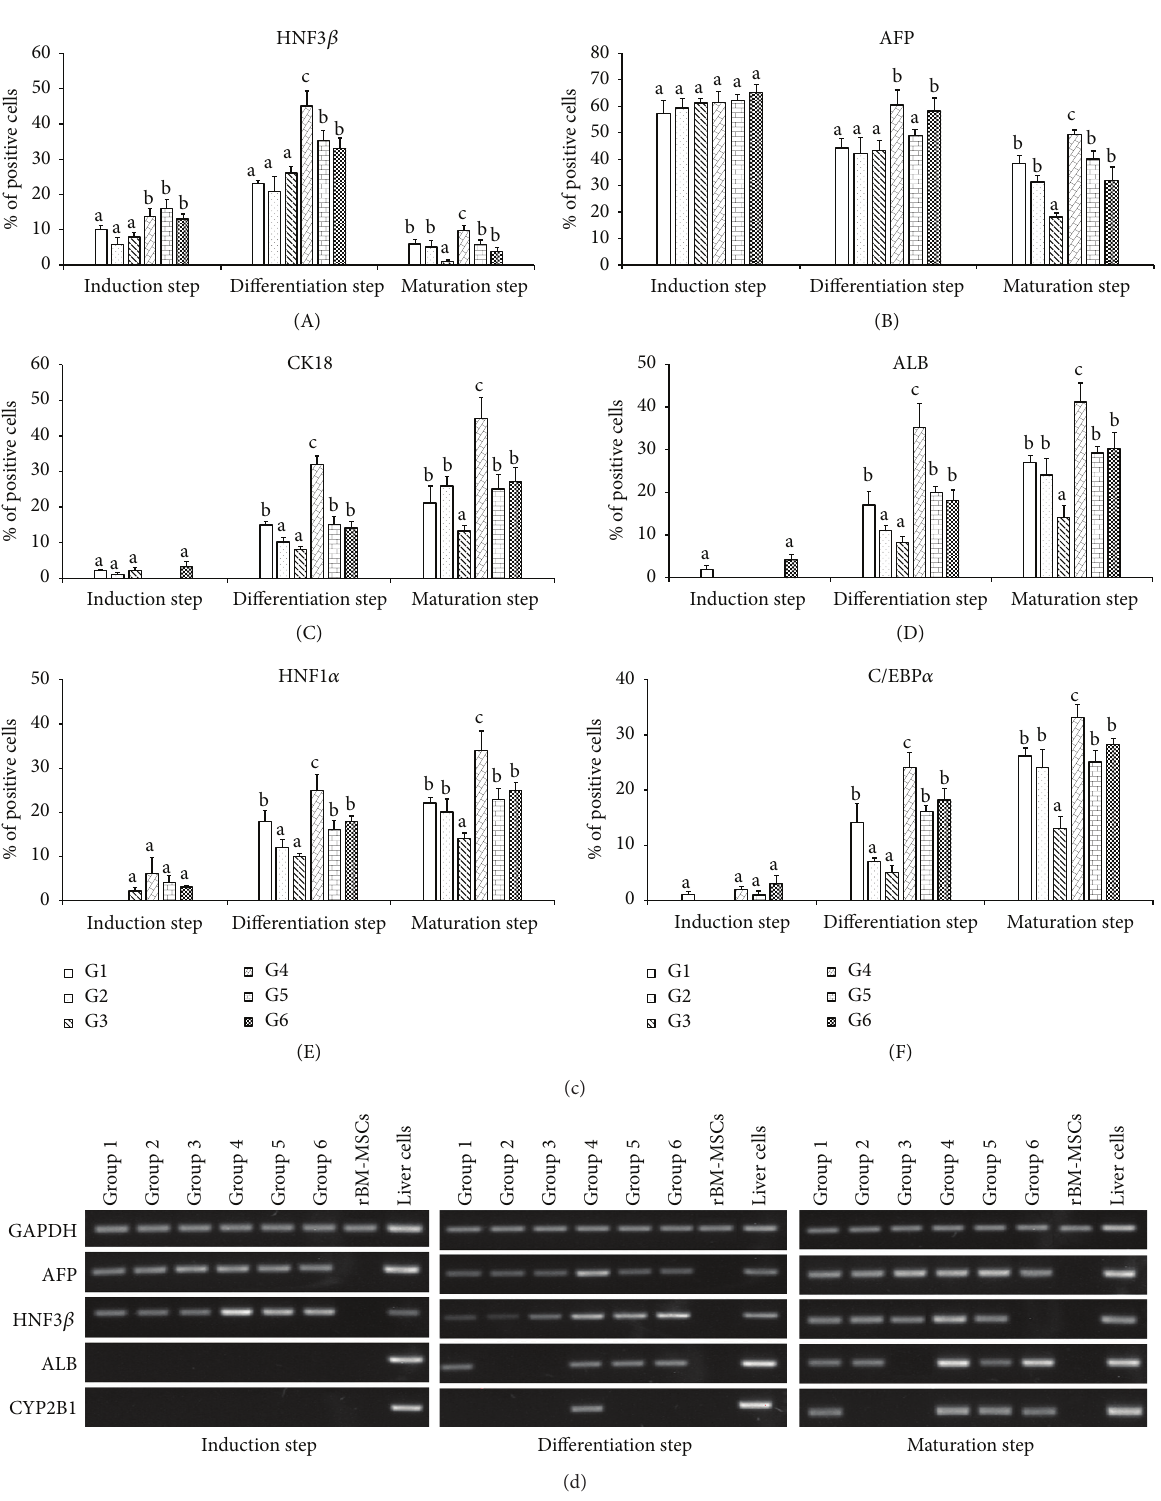
Figure 1: Characterization of differentiated cells. (a) Changes in cell morphology during the hepatic differentiation of rBM-MSCs. Scale bar: 500 𝜇 m. (b) The expression of HNF3 𝛽 , AFP, HNF1 𝛼 , and ALB on the last day of hepatic differentiation in each experimental group, assessed using immunocytochemistry. Scale bar: 200 𝜇 m. (c) Expression of hepatocyte-specific proteins after cell exposure to chromatin-remodeling agents. Immunocytochemistry was performed for HNF3 𝛽 , AFP, CK18, ALB, HNF1 𝛼 , and C/EBP 𝛼 . Values represent means ± SEM. Bars